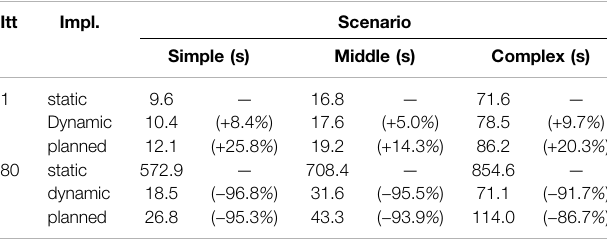
TABLE5| Resultsoftherestartingexperimentperscenariofor1and80iterations.